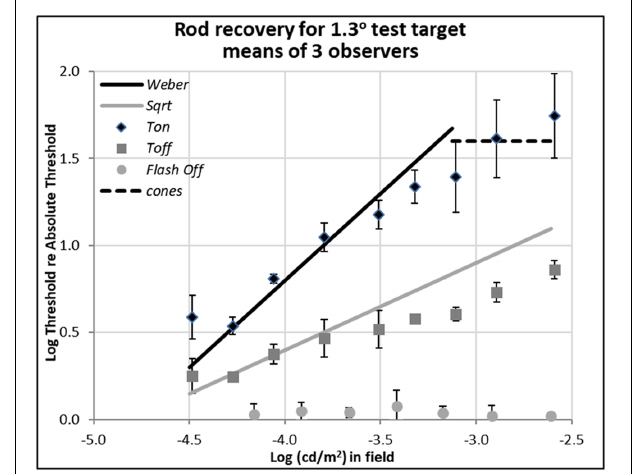
FIGURE 3 | Plots of rod thresholds for detecting a larger target (1.3 ◦ ), either on a steady field ( Ton ) or 600 ms ( Toff ) or 200 ms ( Toff-flash ) in darkness. Thresholds were averaged over three observers and are plotted as a function of log(cd/m 2 ) in the background field. Bars denote ± 1 SE (standard error of the mean) except for Flash Off , where only + 1 SE is shown. Solid black line indicates the Weber prediction and the gray line indicates the square root